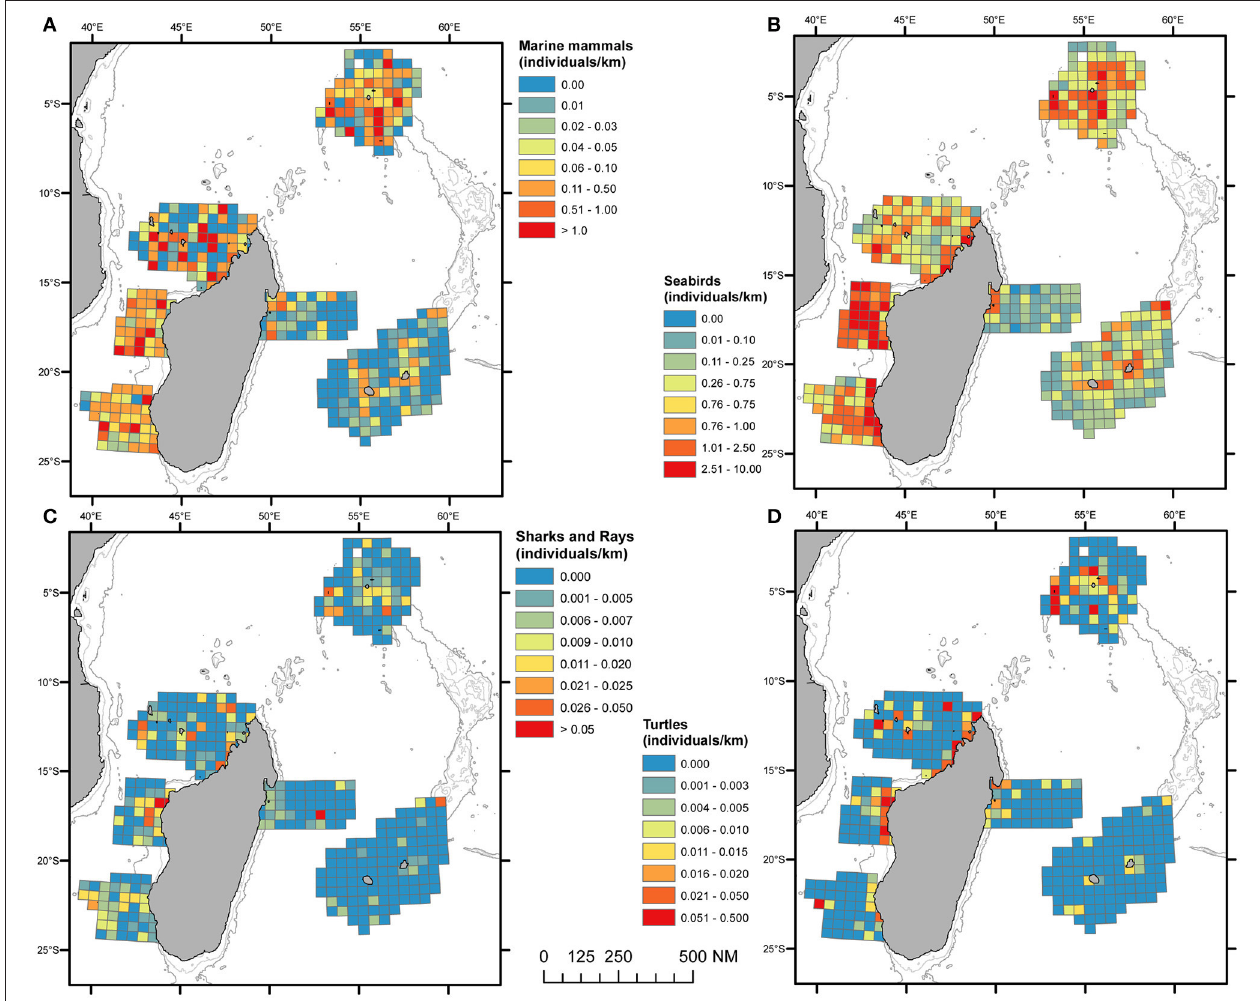
FIGURE 3 | Spatial distribution of marine mammals (A), sea birds (B) , elasmobranchs (C) , and sea turtles (D) , in the SW Indian Ocean. Each pooled on 60 × 60 km grid cell and given in individuals per kilometer. Cells accounting for a minimum effort of 50 km. for pelagic megafauna, ranking first for all general